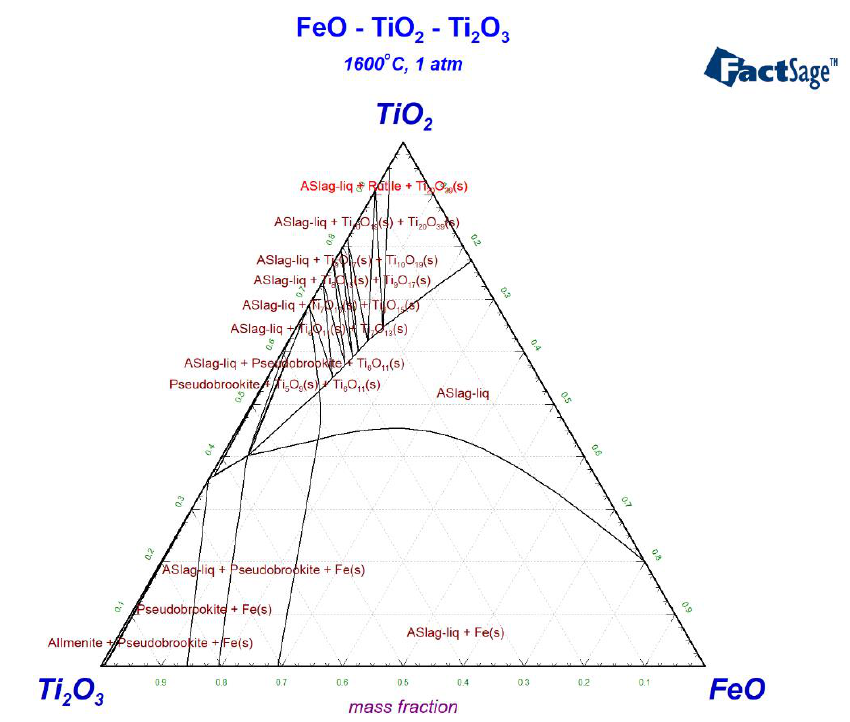
Figure 2. FeO-TiO 2 -Ti 2 O 3 ternary phase diagram at 1600 °C using FactSage version 6.4. The constitution of the ternary phases in the system was similar between 1500 °C and 1600 °C. Pseudobrookite formation was more prominent at 1500 °C with a higher concen- tration of TiO 2 in the system [26]. However, the liquid slag phase was enlarged at 1600 °C, and the magneli phases were solidified, as shown in Figure 2. The bordering phase regions were shifted, accordingly, too.